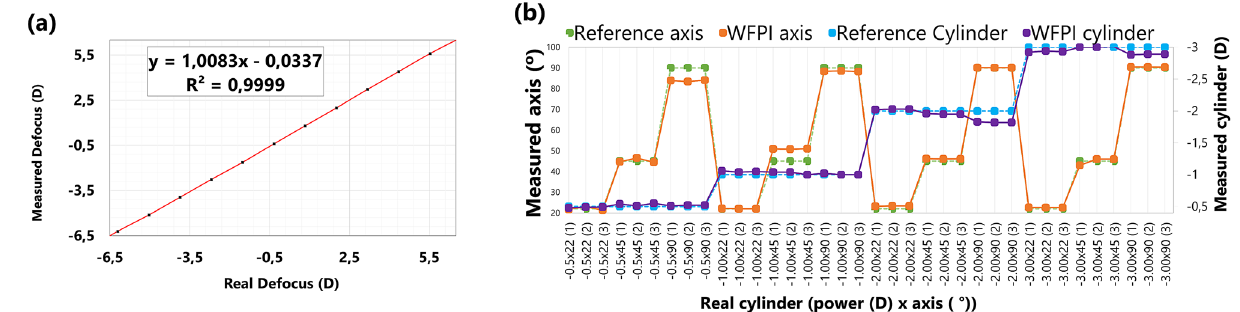
Figure 3. Calibration of the apparatus for different induced defocuses and astigmatisms. (a) Defocus induced in artificial eyes with different axial lengths versus defocus recovered by the apparatus. (b) Different cylindrical trial lenses in different orientations and their measurement with the apparatus. Three different measurements were taken in each condition, and the data were for a 7 mm pupil